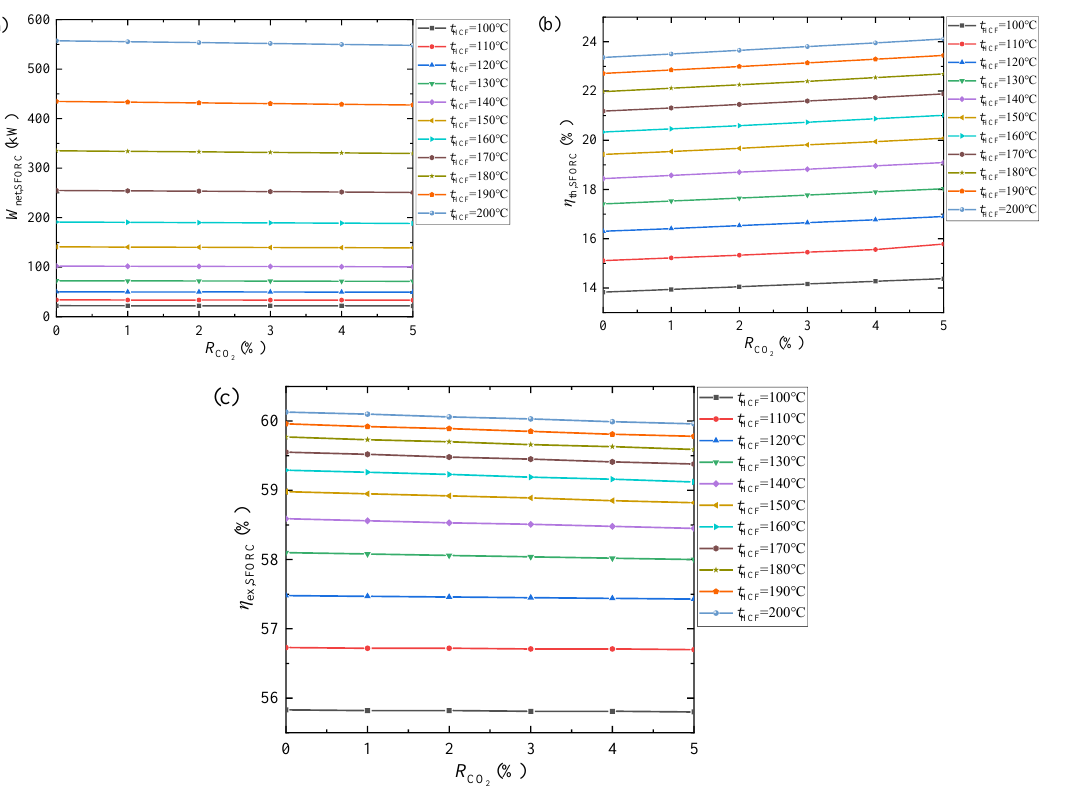
Figure 21. Variation of optimal thermodynamic parameters of the SFORC system with R CO2 at different heat carrier temperatures: ( a ) W net, SFORC , ( b ) η th, SFORC and ( c ) η ex, SFORC